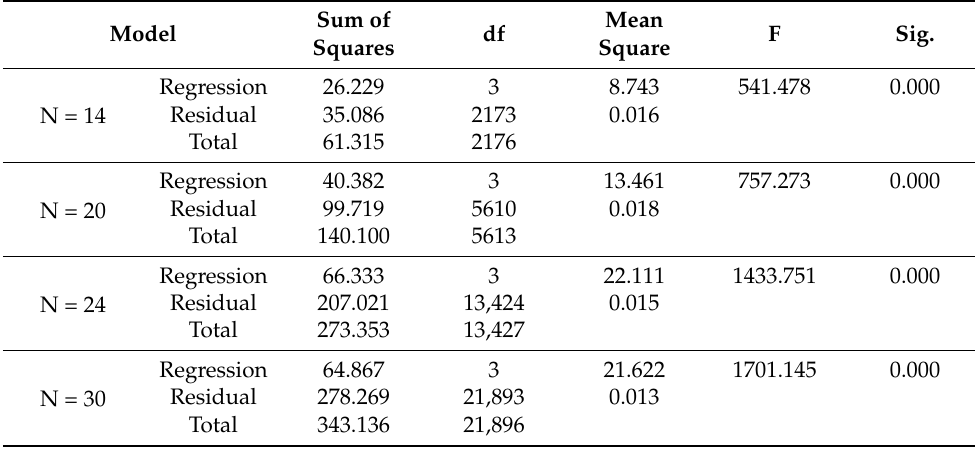
Table 1. ANOVA results for the multiple regression models for